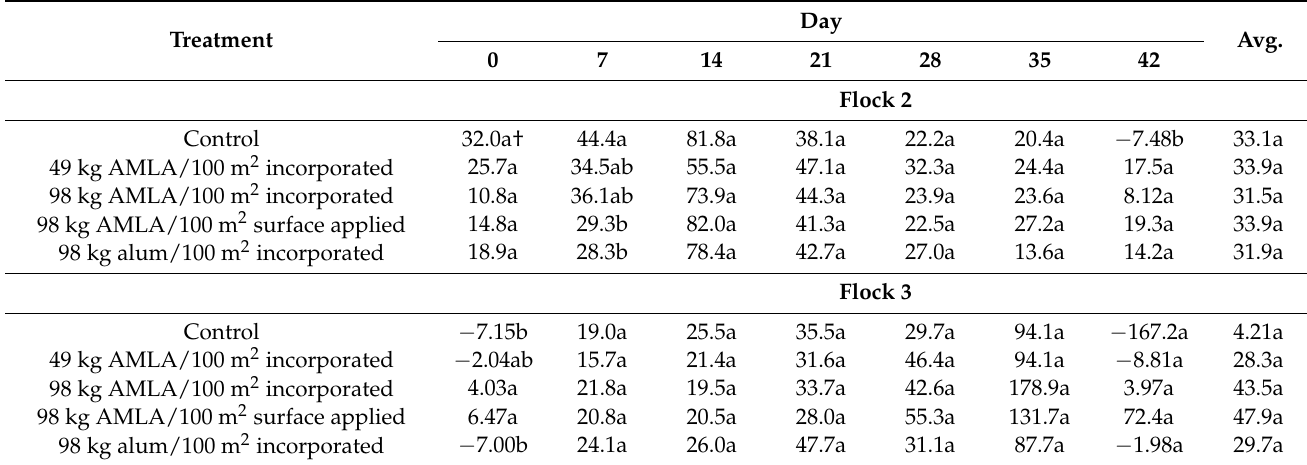
Table 3. Average methane flux (mg CH 4 m − 2 hr − 1 ) for flock 2 and 3 by treatment and sampling date.